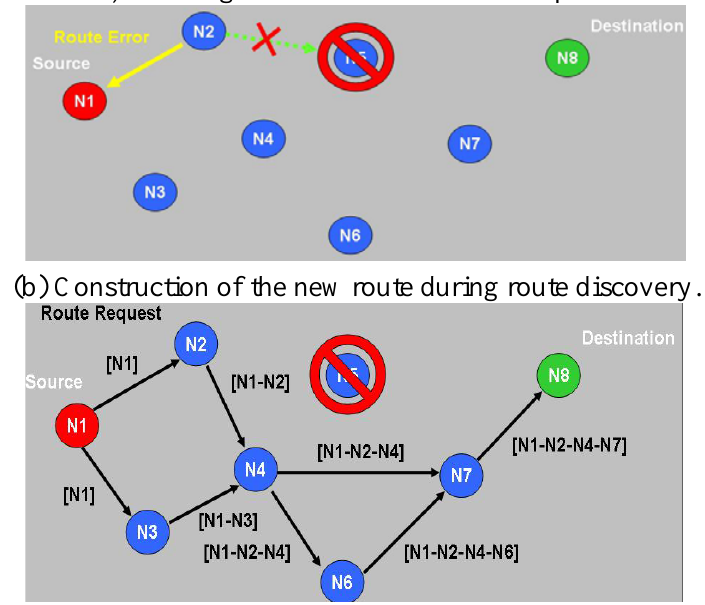
Figure 4. Route maintenance in DSR